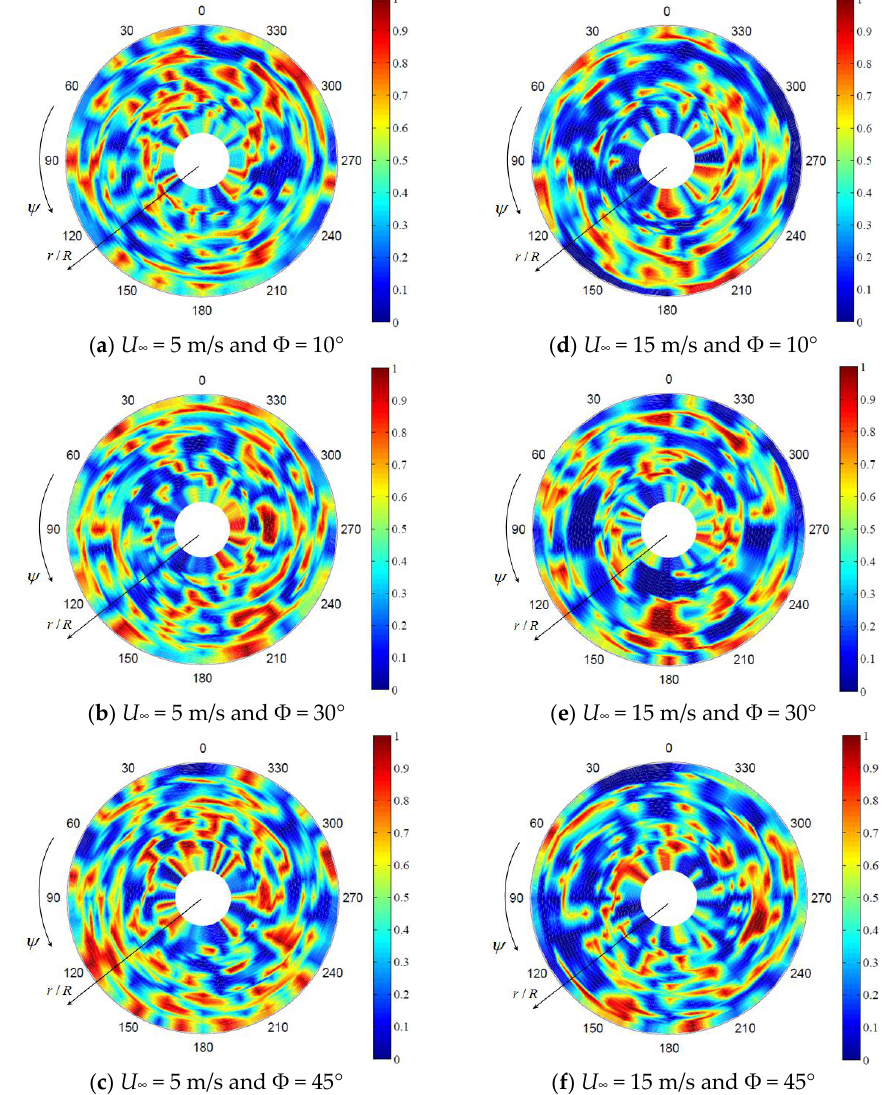
Figure 15. Illustration for the locations of the normally and non-normally distributed C T data bins. Different colors and the bar indicate the probability ( p- value) determined using Shapiro–Wilk’s test. p- value > 0.05 indicates that data are normally distributed.